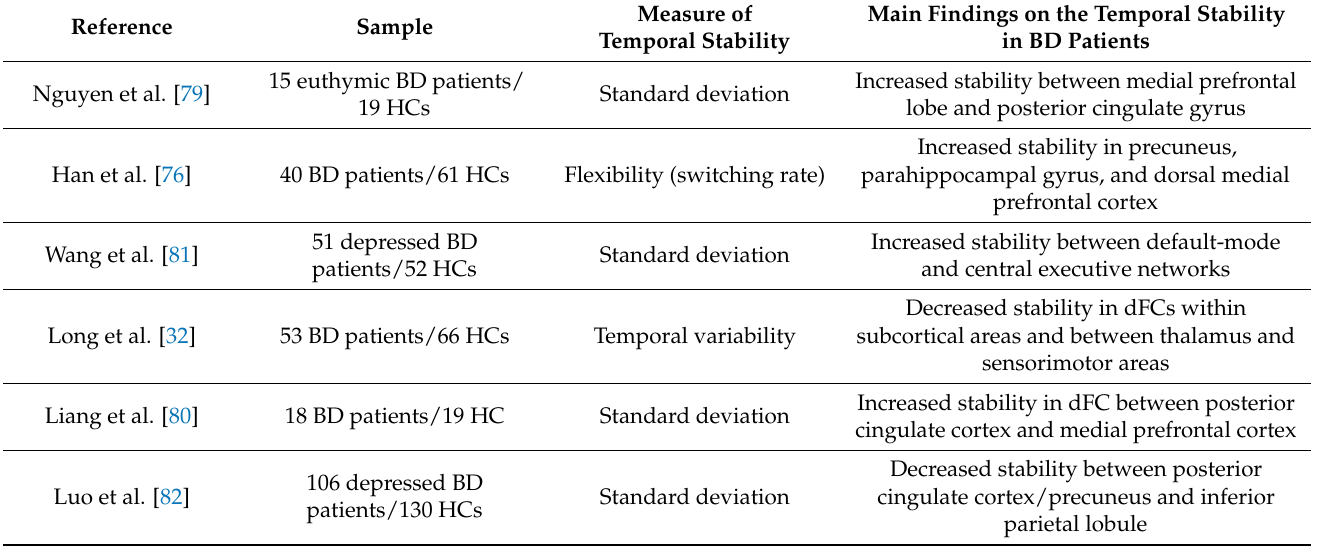
Table 3. Summary of main findings of changes in the temporal stability of brain network in patients with bipolar disorder (BD) as mentioned in this manuscript. dFC, dynamic functional connectivity; HCs, healthy